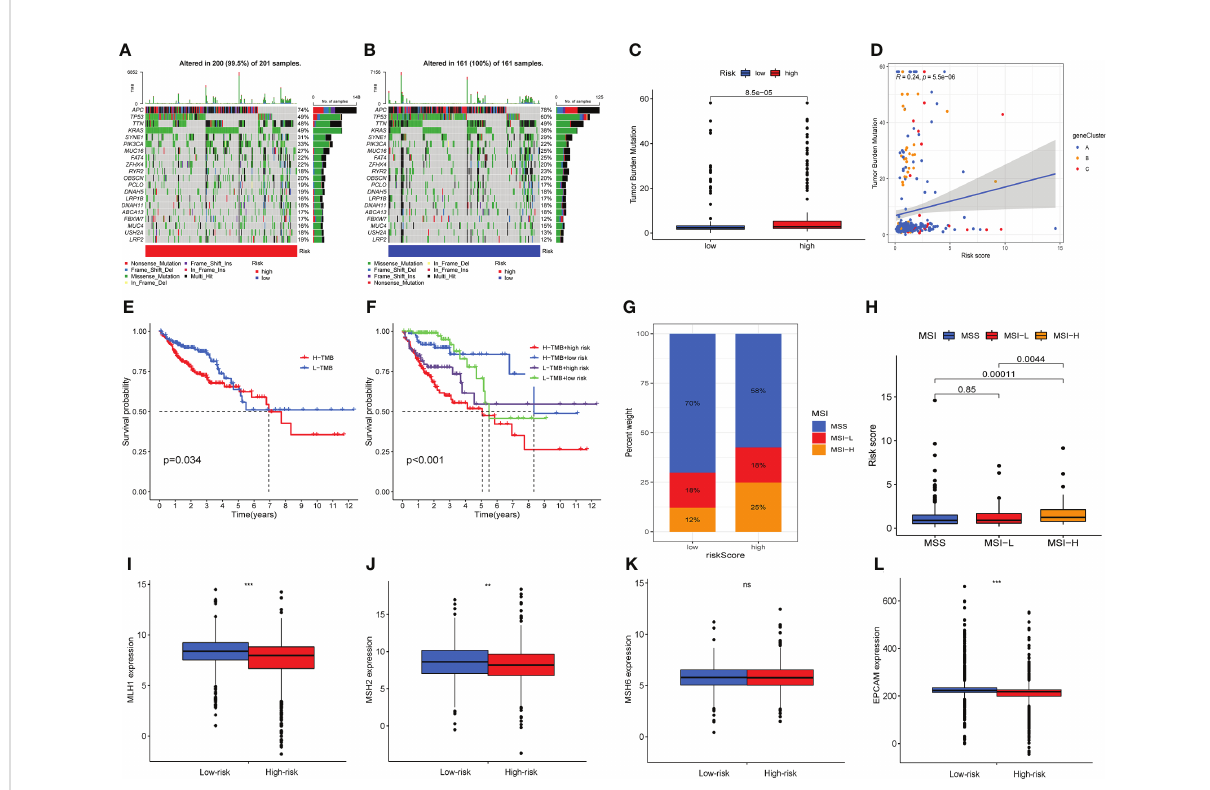
FIGURE 8 Association between ARG score and tumor mutation burden (TMB) along with microsatellite instability (MSI). The waterfall plot of 20 genes with the highest mutation rates in high-risk (A) and low-risk groups (B) . (C) Differences in tumor mutational burden between high-risk and low-risk groups. (D) Correlation between tumor mutational burden and risk score. (E) Survival analysis shows the OS differences between two TMB subgroups. (E) Survival analysis shows OS differences strati fi ed by TMB and risk score. (F) The proportion of MSS, MSI-L and MSI-H in different risk groups. (F) Differences in risk score between MSS, MSI-L and MSI-H subgroups. (I – L) Expression levels of four mismatch repair related genes in different risk groups. Adjusted p-values were shown as ns, no signi fi cant, ** P < 0.01, *** P <